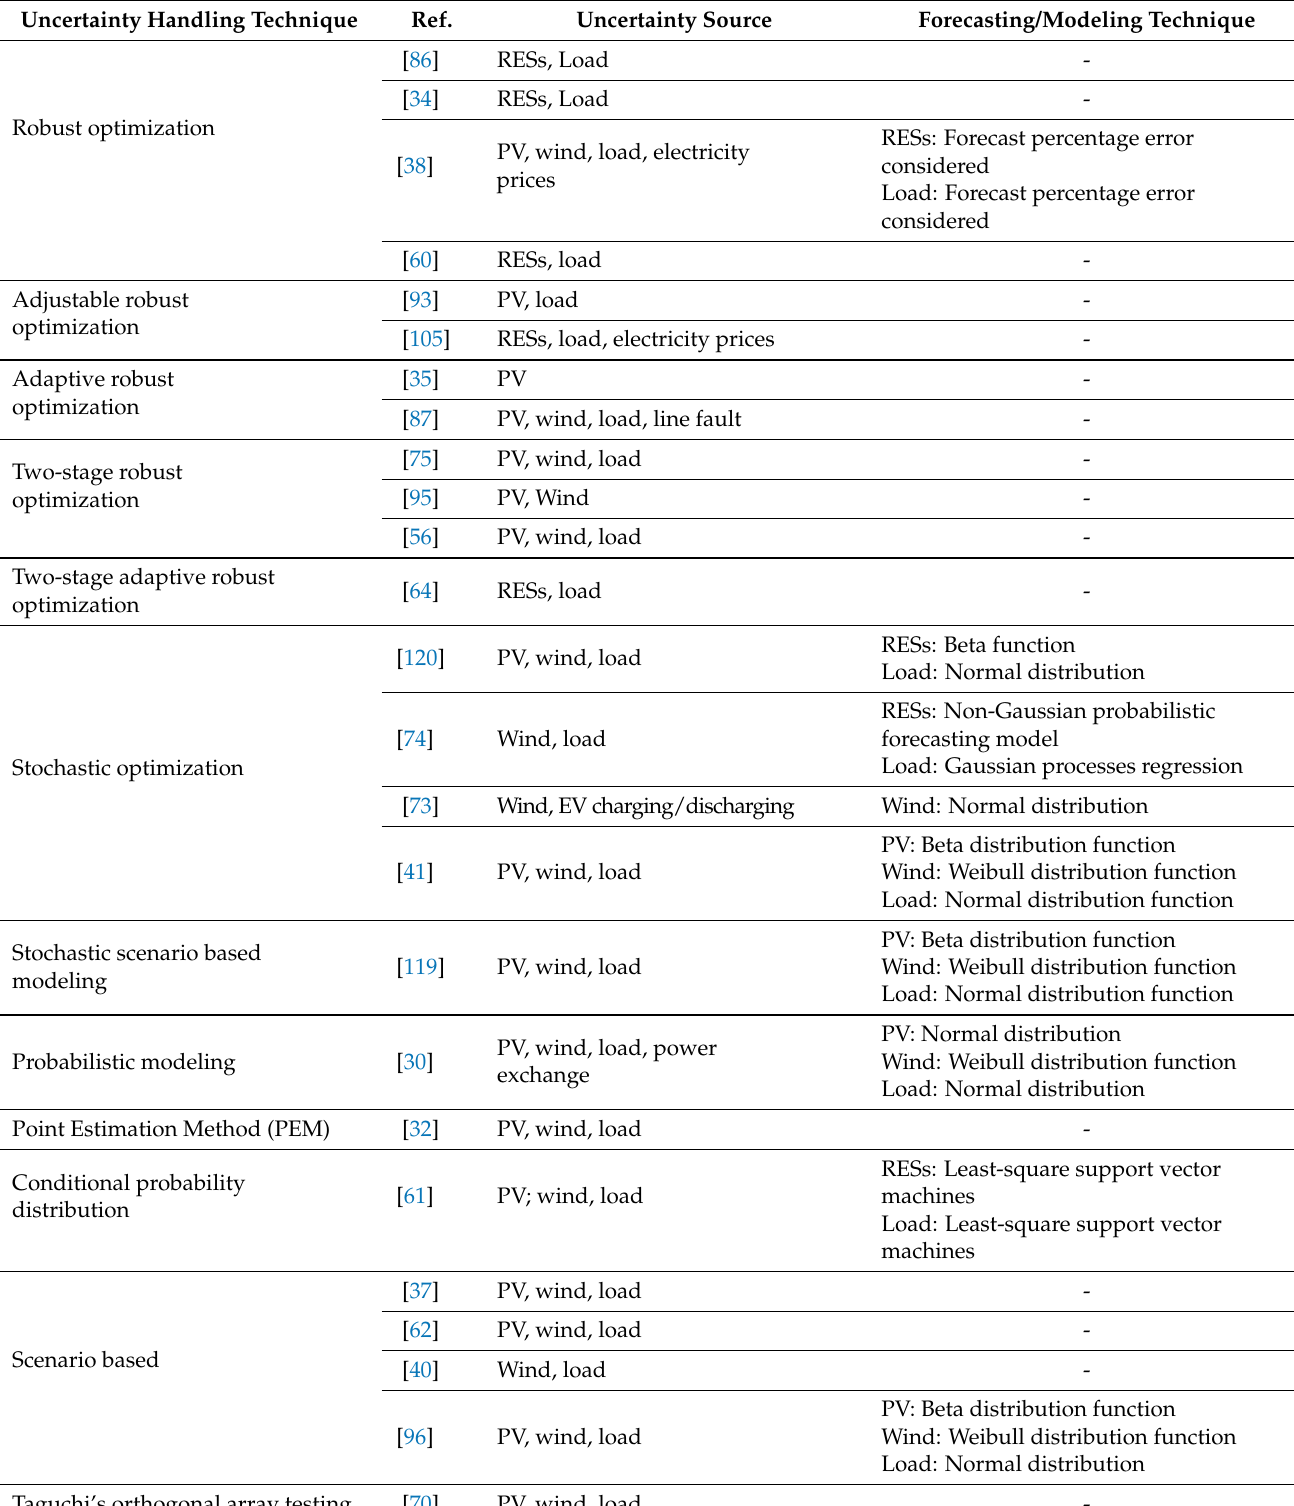
Table A5. Uncertainty handling techniques and uncertainty